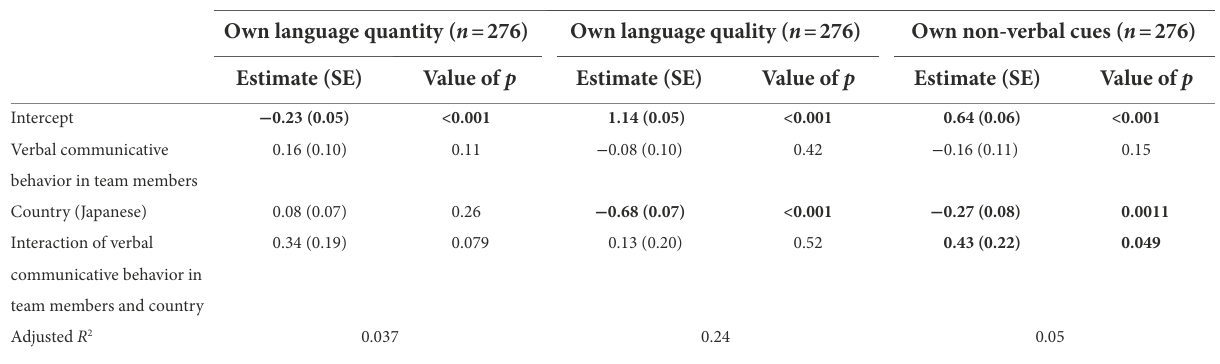
TABLE 5 The linear regression models predicting educators’ own communicative behavior toward team members.